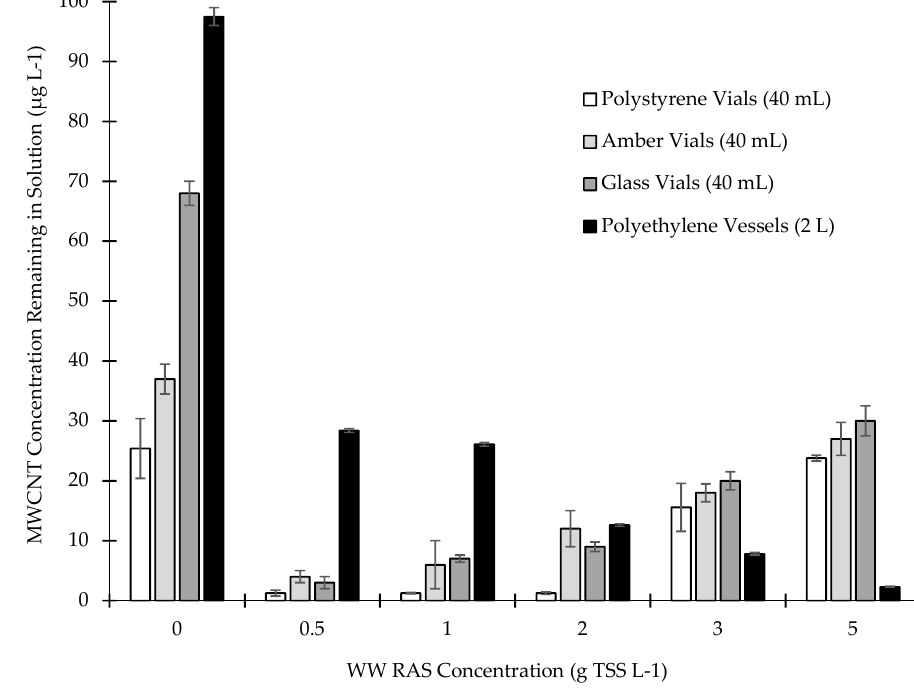
Figure 6. Effect of different vessels on MWCNTs removal by return activated sludge. Figure 6. E ff ect of di ff erent vessels on MWCNTs removal by return activated